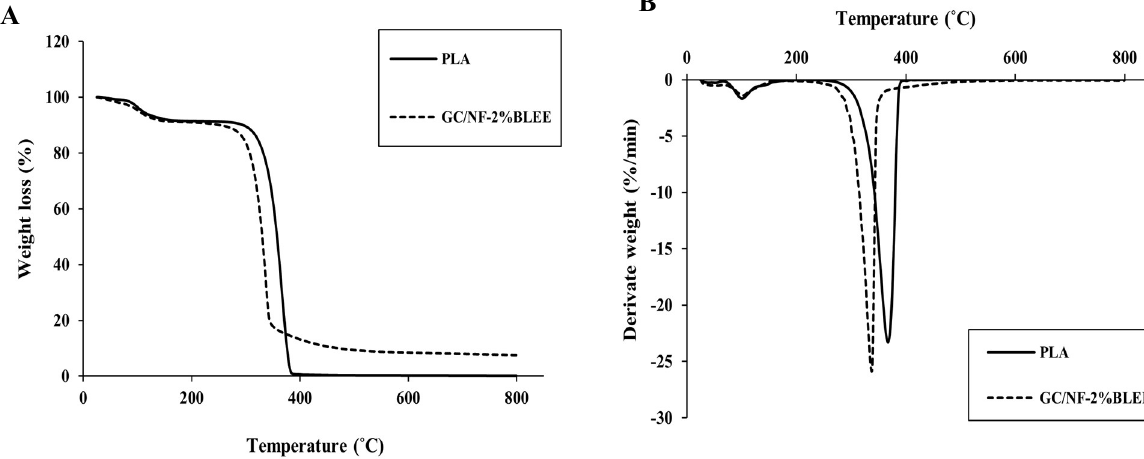
Figure 2. Thermogravimetric analysis ( A ) and derivative weight loss ( B ) thermograms of GC/NF- 2%BLEE film and PLA film.